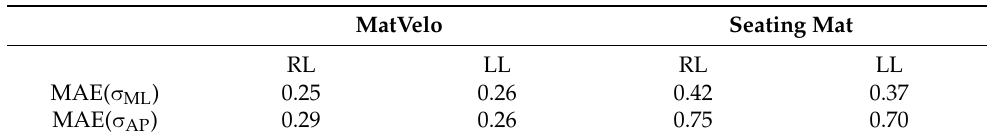
Table 4. MAE (cm) of our PSM and the commercial PSM, where MAE( σ ML ) and MAE( σ AP ) are the mean absolute errors of the standard deviation of the ML and AP components, respectively. RL, right-leg trial; LL, left-leg trial. MatVelo Seating Mat